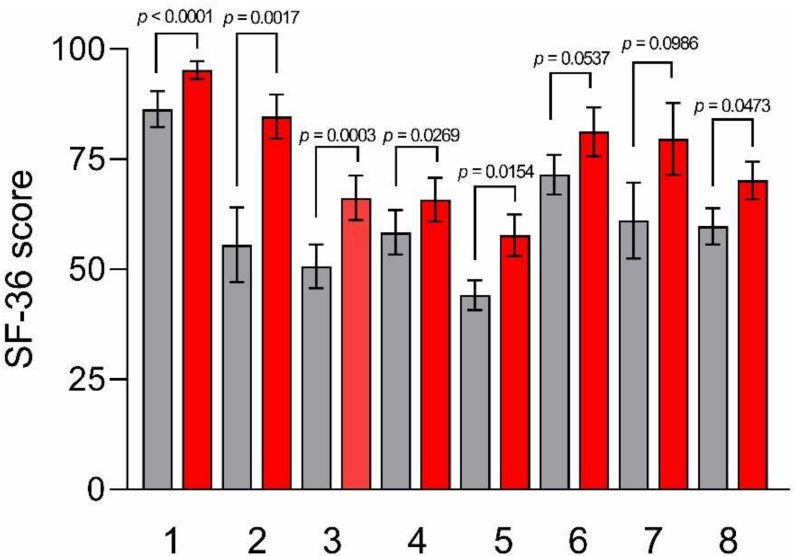
Figure 3. SF-36 subscale scores before and after the Tritordeum-based diet. Data are expressed as means ± SEM and analyzed by the Wilcoxon matched-pairs signed rank test. All differences were considered significant at p < 0.05. Subscales: ( 1 ) physical function; ( 2 ) role physical; ( 3 ) body pain; ( 4 ) general health; ( 5 ) vitality; ( 6 ) social functioning; ( 7 ) role emotional; and ( 8 ) mental health. Grey columns (Pre-diet), red columns